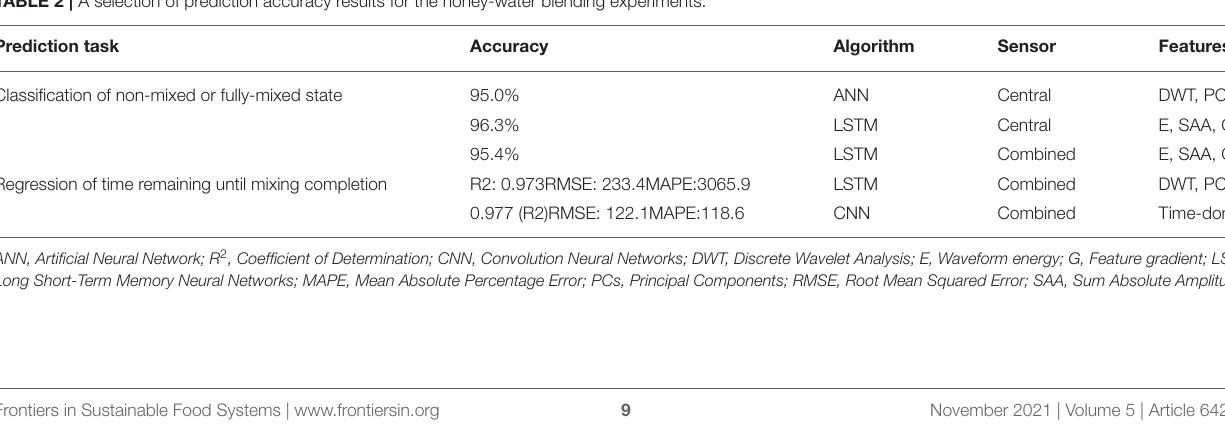
TABLE 2 | A selection of prediction accuracy results for the honey-water blending